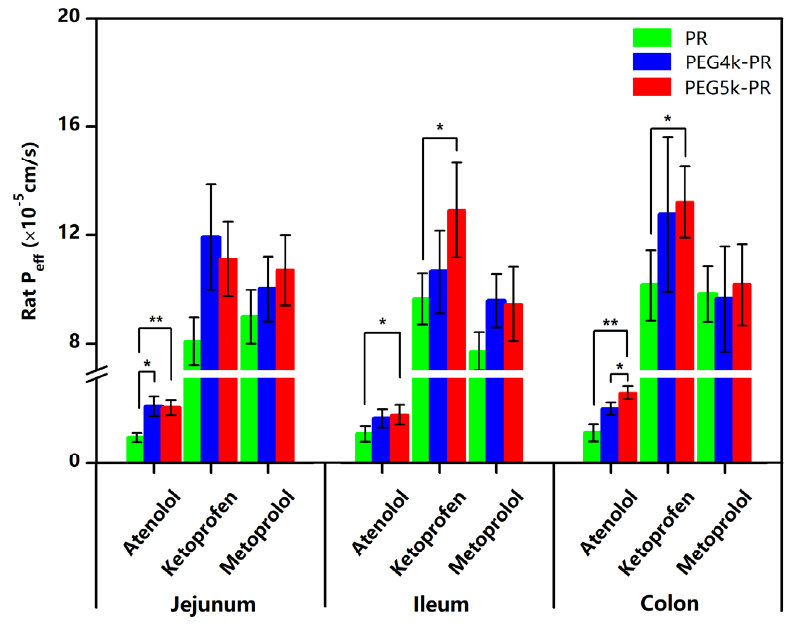
Figure 10. E ff ective intestinal membrane permeability ( P e ff ) of atenolol, ketoprofen, and metoprolol Figure 10. Effective intestinal membrane permeability ( P eff ) of atenolol, ketoprofen, and metoprolol corrected by PR, PEG4k-PR, and PEG5k-PR in di ff erent intestinal segments. Data are shown as corrected by PR, PEG4k-PR, and PEG5k-PR in different intestinal segments. Data are shown as mean mean ± SD, n = 3; * p < 0.05 and ** p < 0.01. ± SD, n = 3; * p < 0.05 and ** p < 0.01.